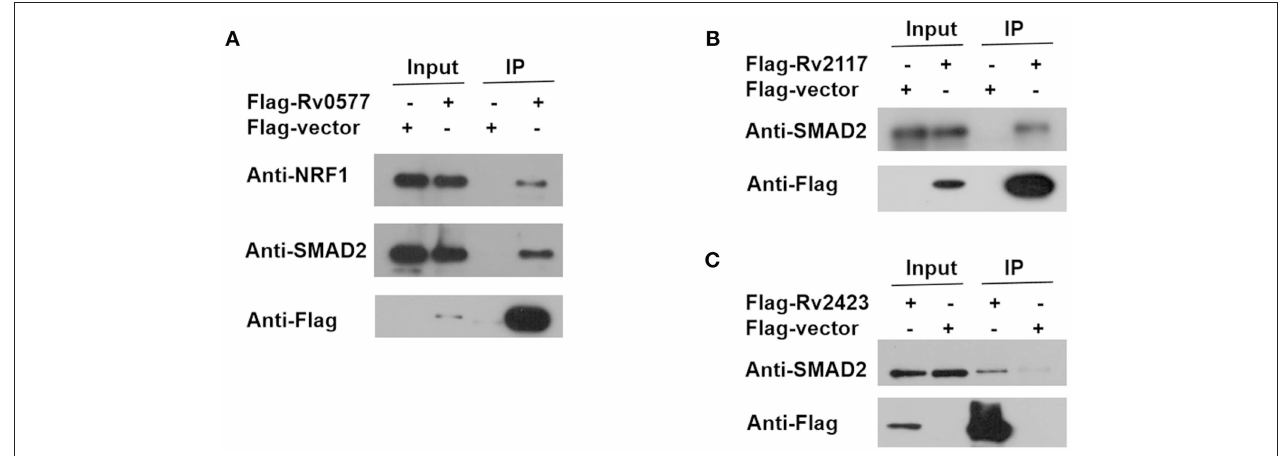
FIGURE 6 | Co-IP of endogenous NRF1 with Rv0577 and endogenous SMAD2 with Rv0577, Rv2117, and Rv2423. (A) Co-IP of Flag-Rv0577 with endogenously expressed NRF1 and SMAD2. (B,C) Co-IP of Flag-Rv2117 and Flag-Rv2423 with endogenously expressed SMAD2, respectively. Western blot shown are representative of two independent